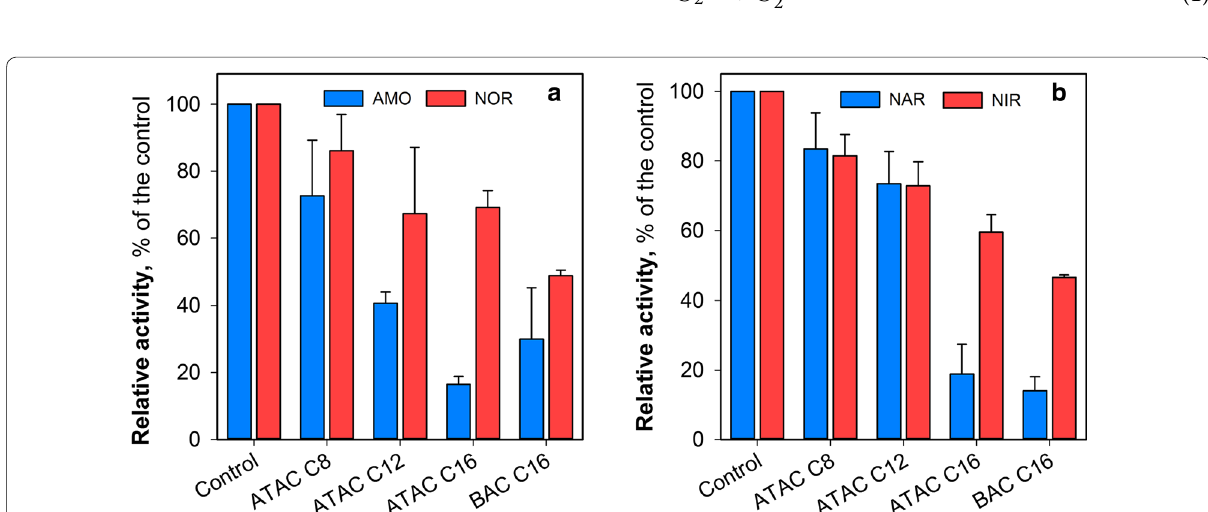
Fig. 2 Variations of a AMO and NOR, and b NAR and NIR activities of the sludge samples following 2-h exposure to QACs. Tests were conducted at least in